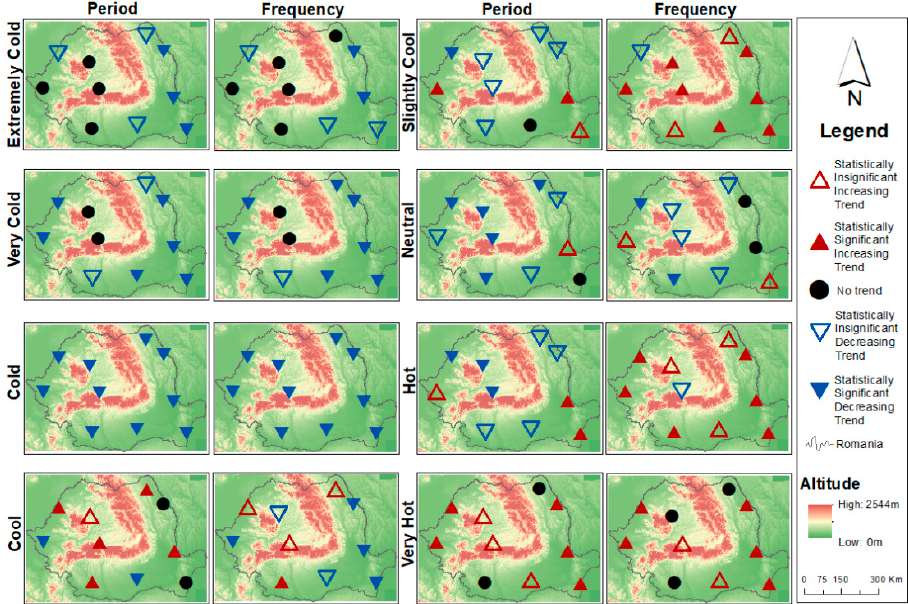
Figure 10. Spatial distribution of the trends detected for the H index.